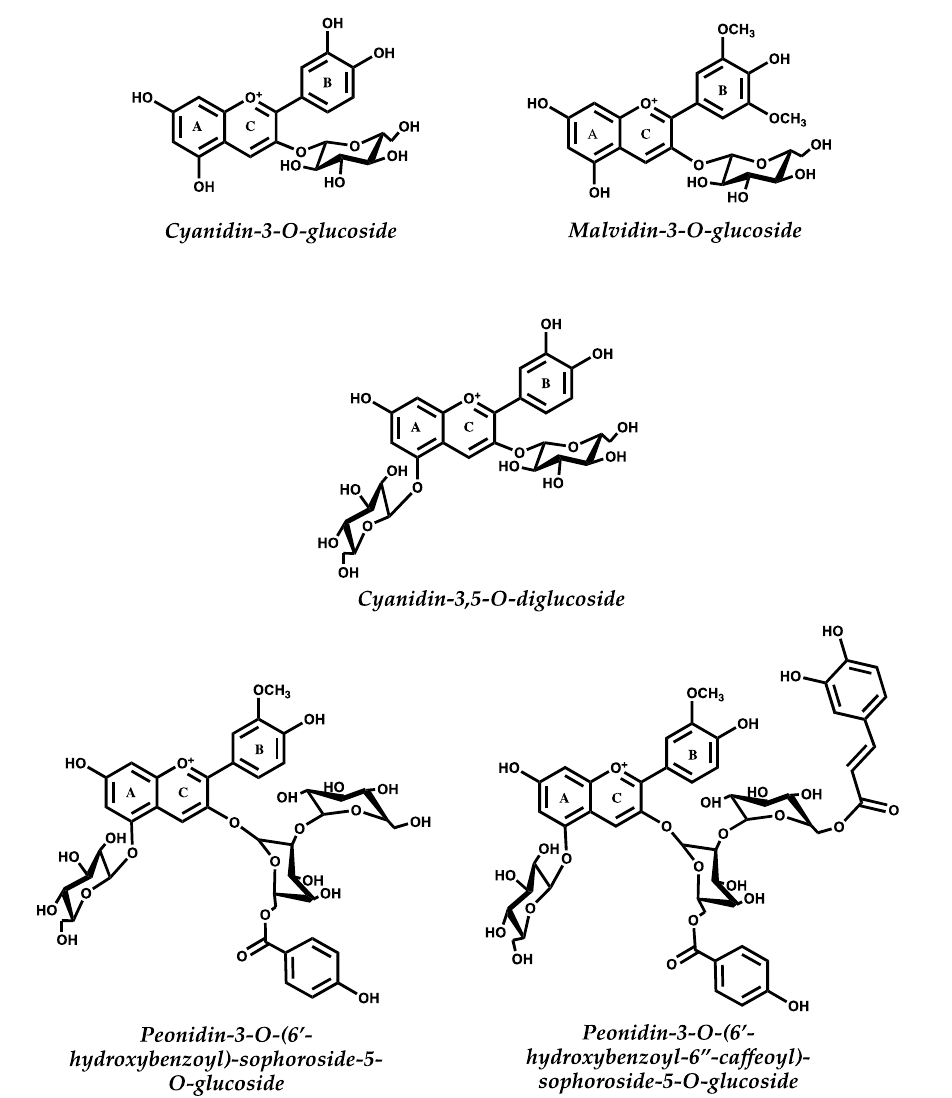
Figure 1. Structure of different anthocyanins (flavylium cation form) commonly found in typical diets. Cyanidin-3- O -glucoside can be found in different berries, while cyanidin-3,5- O -diglucoside may be found in pomegranates. Malvidin-3- O -glucoside is the main anthocyanin in Vitis vinifera grapes and red wine, while sophoroside anthocyanins are abundant in purple sweet potato and purple cabbage.